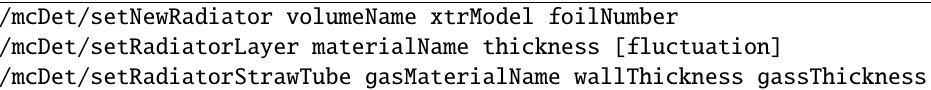
Table 2. User interface commands to define radiator